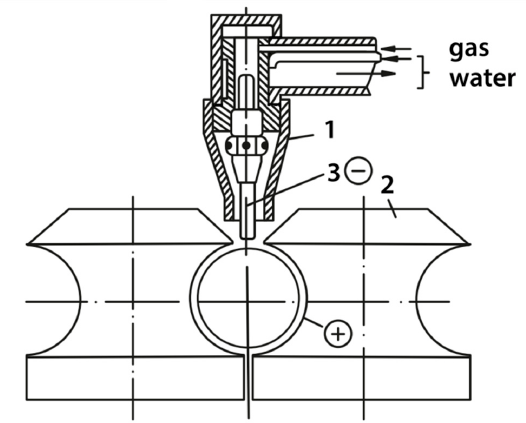
Figure 2. Seam tubes welding by the tungsten inert gas (TIG) method: 1—nozzle, 2—calibration pulleys creating additional pressure, 3—non-consumable tungsten electrode.